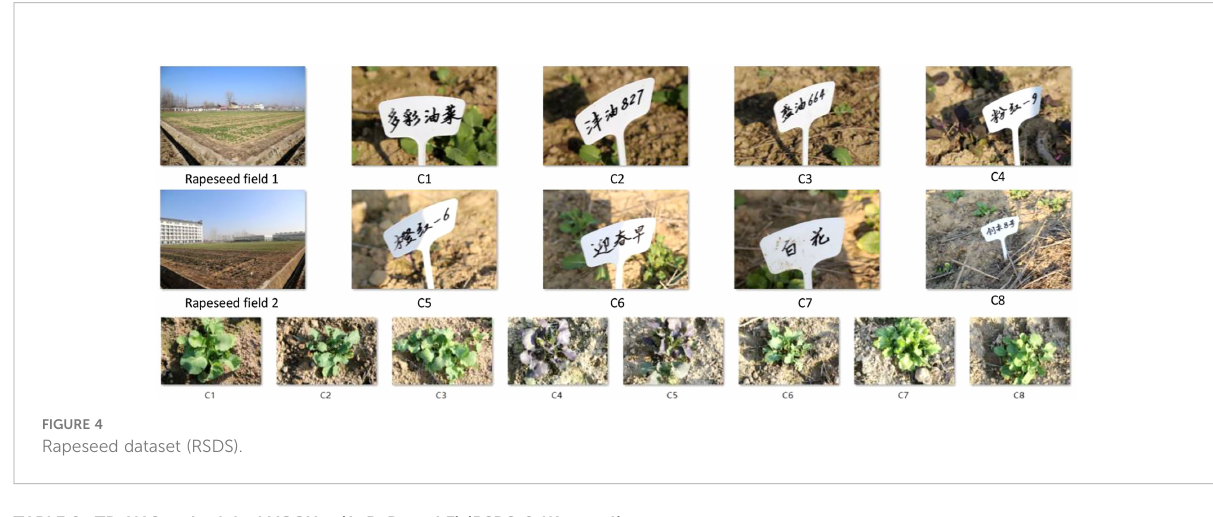
(Table 4) to search for TD-NAS on VGGNet-D (VGGNet-16).